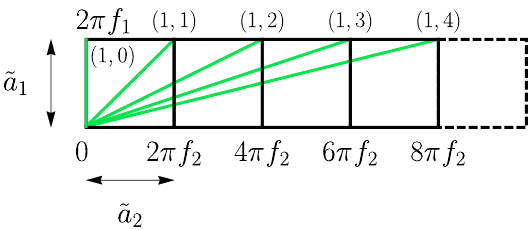
Figure 3. The string solutions in the domain map of (~ a 1 ; ~ a 2 ) for given ( n 1 ; n 2 ). The compensated string, (1 ; 4), corresponds to the direction of the orbit of the gauge transformation in (cid:12)gure 1. The uncompensated string winds not only in the direction of the would-be Goldstone boson but also in the gauge-invariant Goldstone